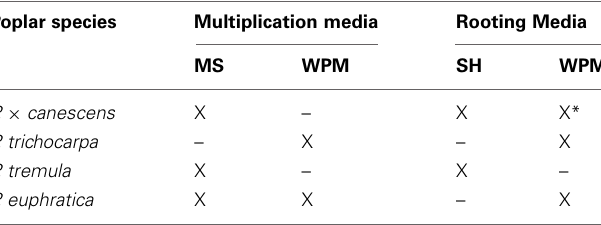
Table 1 | Multiplication and rooting media for different poplar